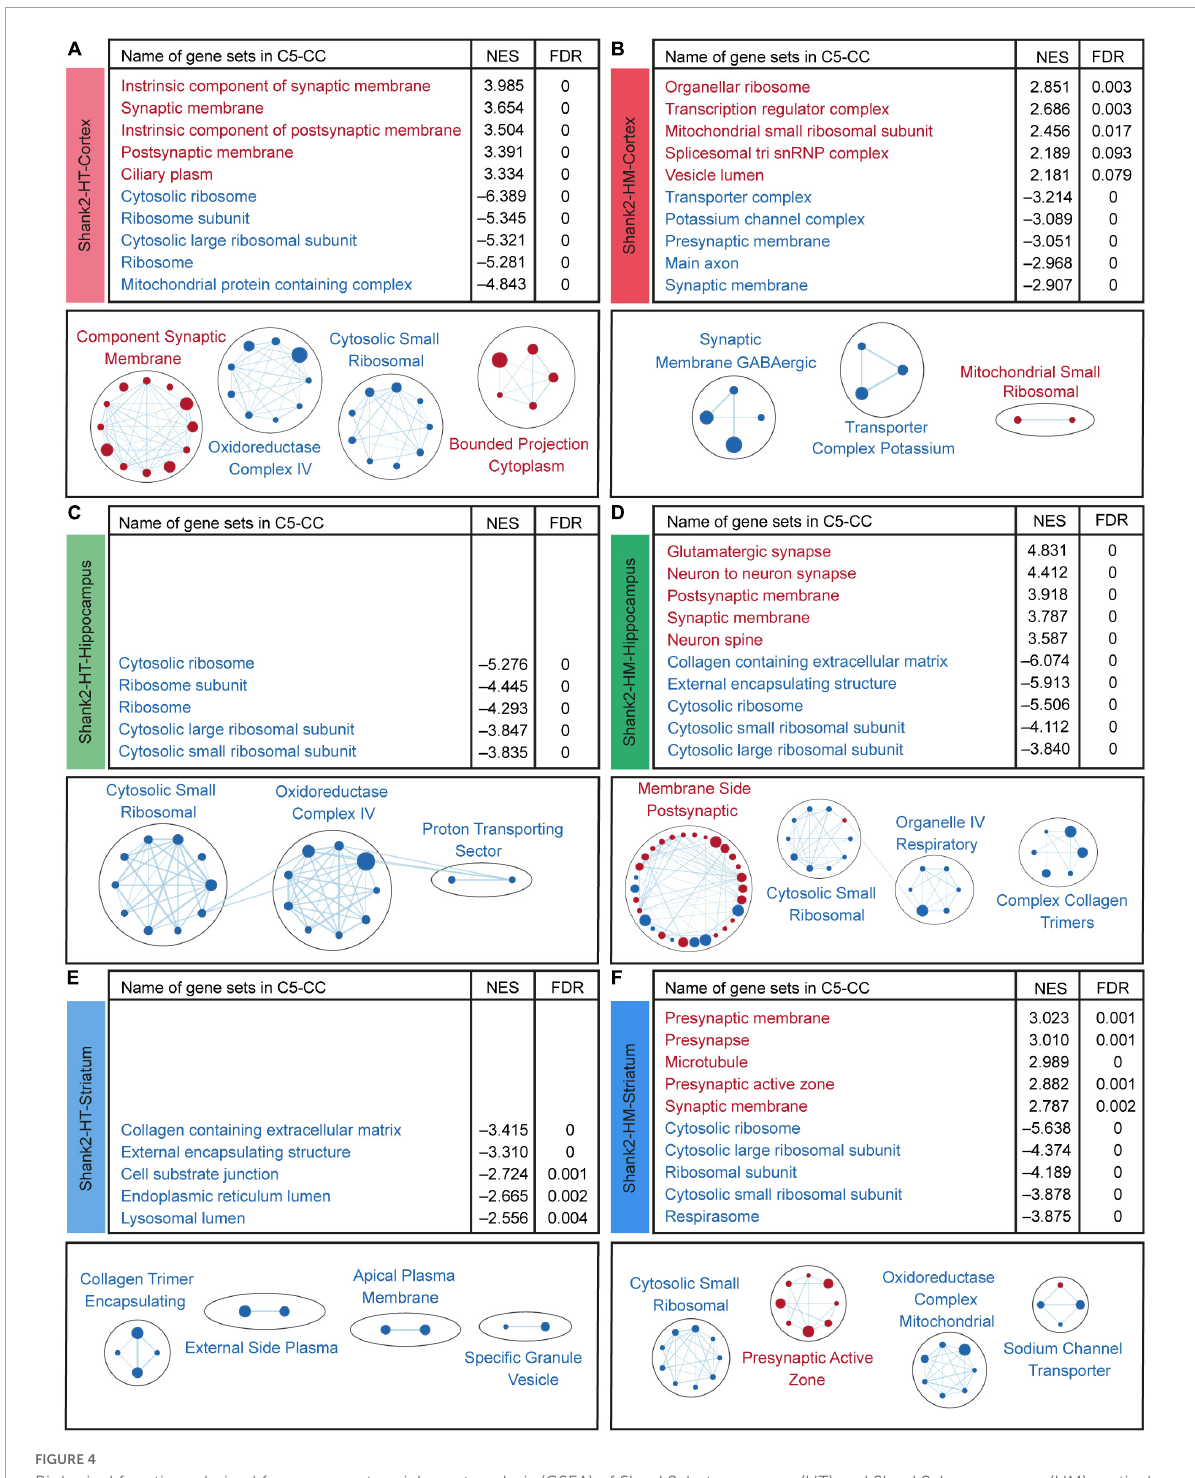
FIGURE4 Biological functions derived from gene set enrichment analysis (GSEA) of Shank2-heterozygous (HT) and Shank2-homozygous (HM) cortical, hippocampal, and striatal transcripts. (A–F) GSEA results for Shank2-HT/HM cortical/hippocampal/striatal transcripts showing a list of the top five positively (red) and negatively (blue) enriched gene sets (top), and their integrated visualization generated using the Cytoscape App, EnrichmentMap (bottom). Only the results for C5-cellular component (CC) are shown here; those for C5-biological process (BP) and C5-molecular function (MF) are shown in Supplementary Figures 3–5 . Note that only the top five gene sets are shown here (see Supplementary Table 3 for full results). In the EnrichmentMap results, each circle in a cluster indicates a significantly [false discovery rate (FDR) < 0.05] enriched gene set; the circle sizes and colors (red/blue) indicate the gene-set size and positive/negative enrichment based on NES scores, respectively [ n = 5 mice (Shank2-HT/HM cortex, hippocampus, and